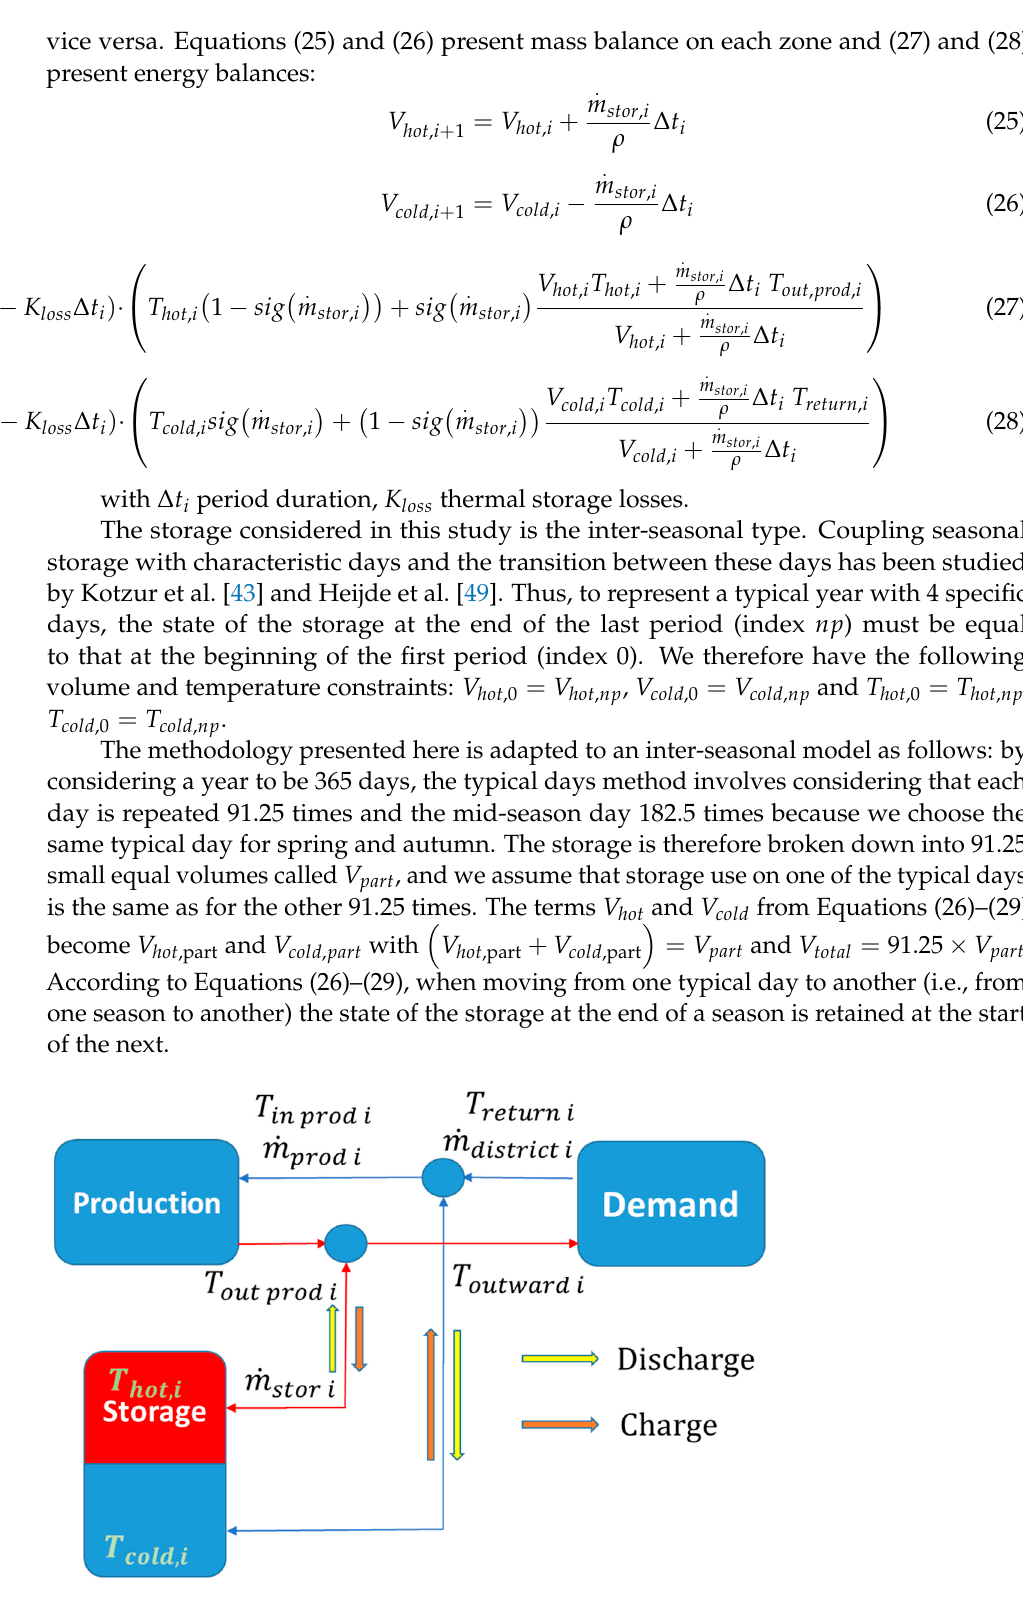
Figure 6. Connection of storage to the